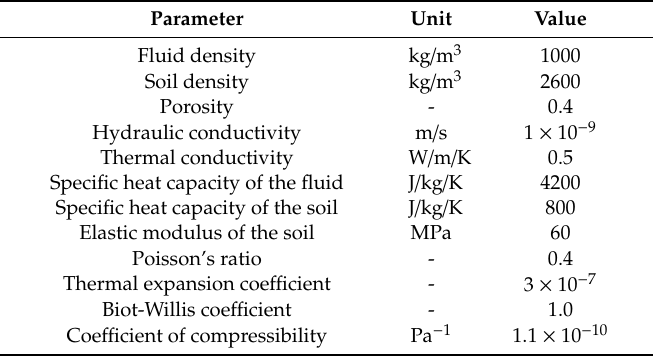
Figure 10. Comparison of analytical and numerical solution of temperature at different positions.